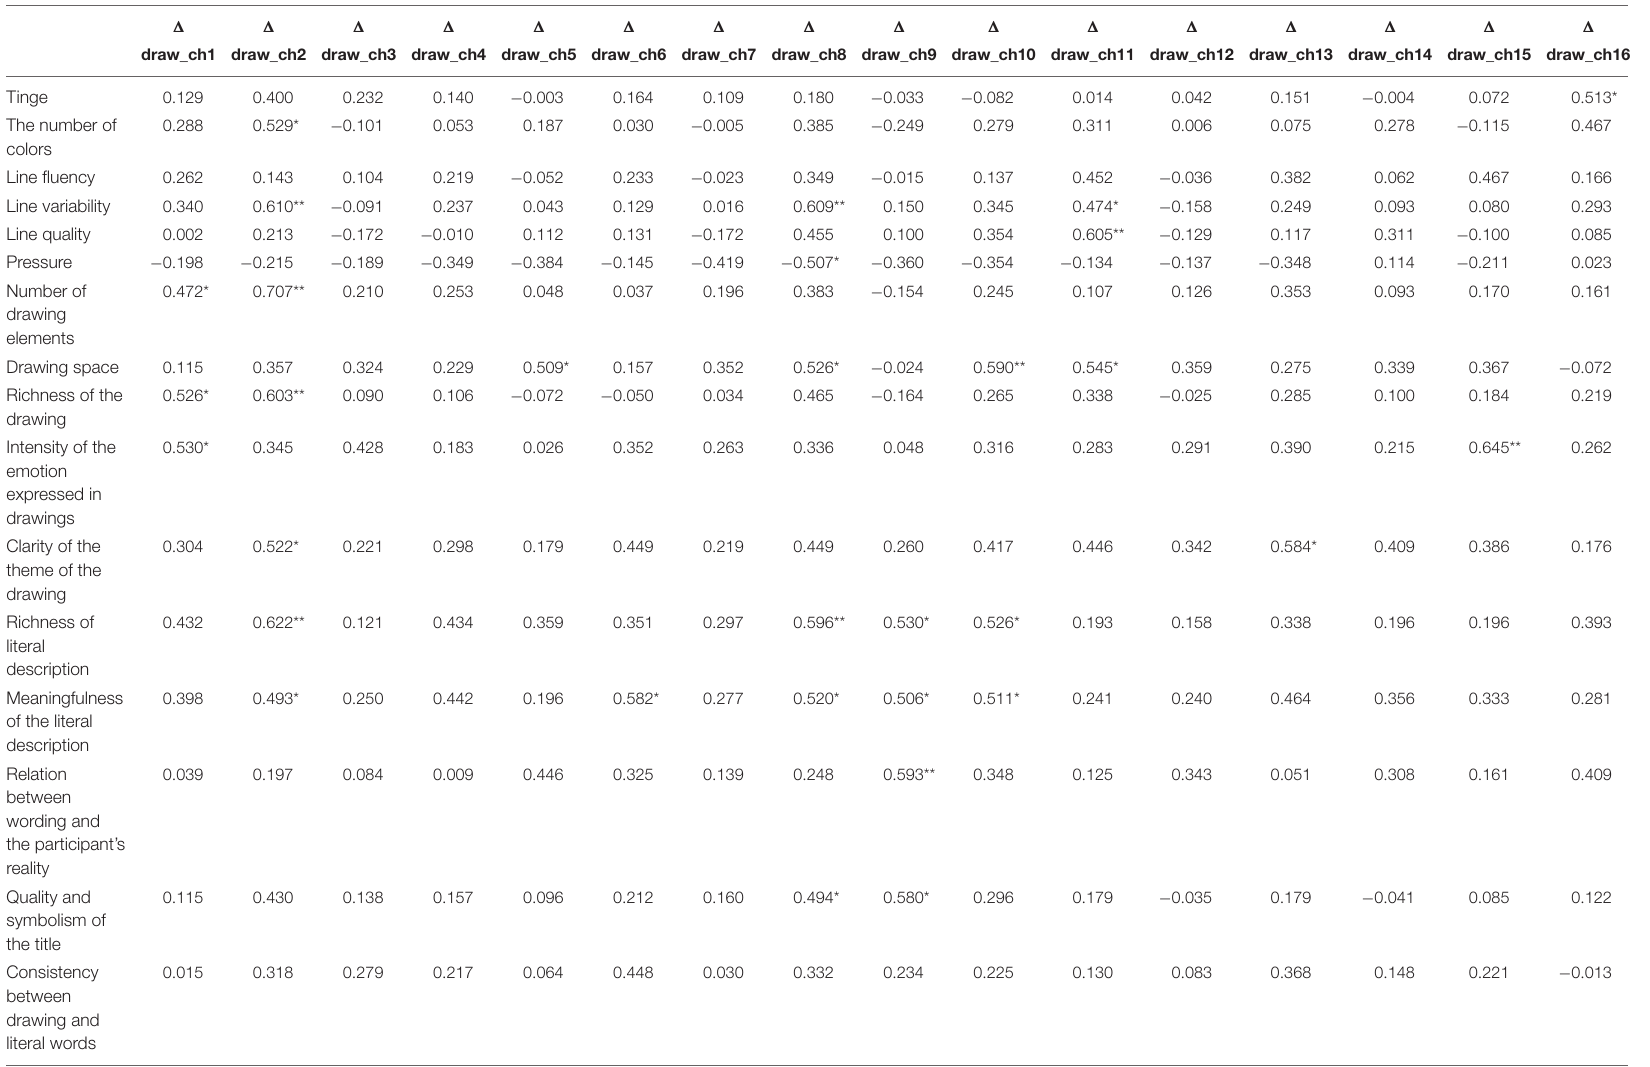
TABLE 7 | Correlation coefficients between drawing coding and brain data in the healthy group during the emotional expression